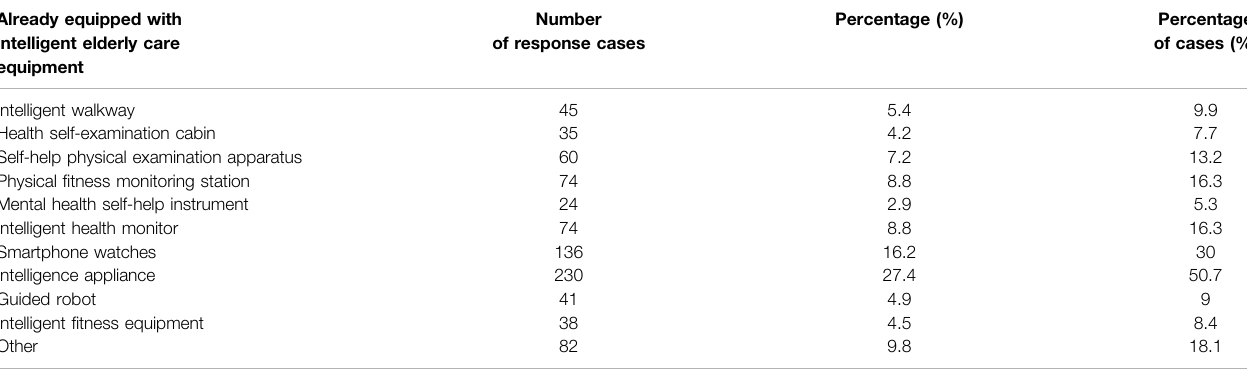
TABLE 7 | Equipped with smart elderly service